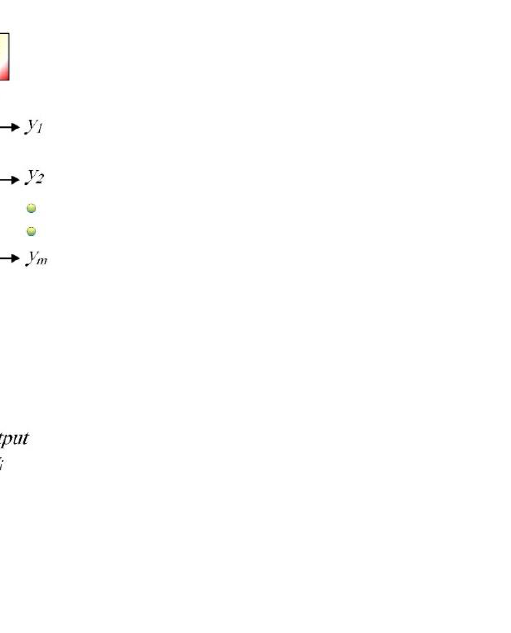
Figure 3. ( a ) The structure of MLP model and ( b ) a perceptron with a bias, summing, and activation functions.